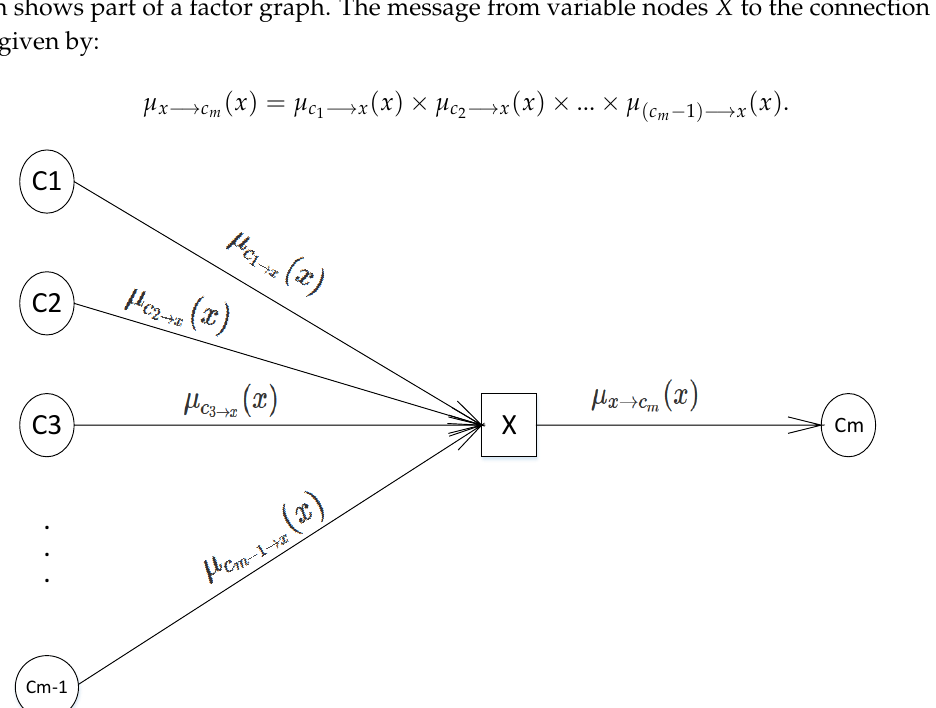
Figure 2. Message from variable node to the connection